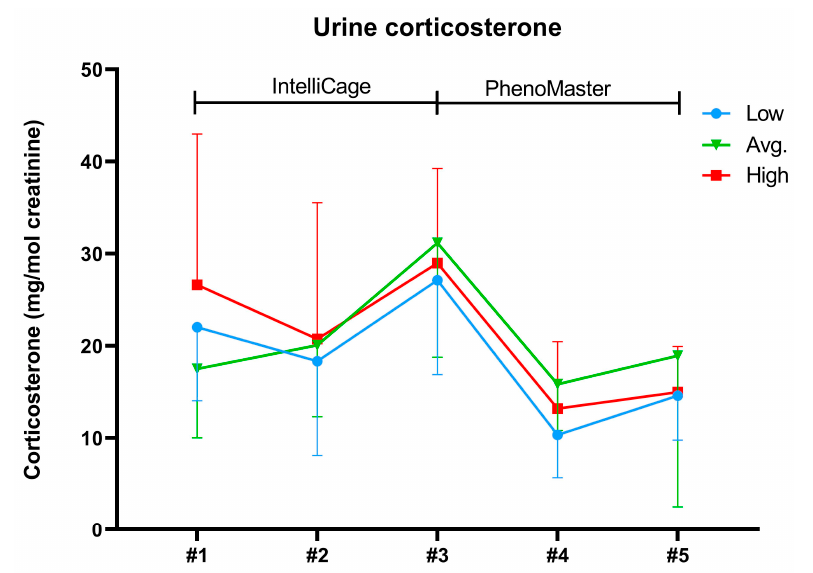
Figure 4. Urine corticosterone levels normalized to creatinine in the running wheel groups (Low; n = 7, Avg.; n = 8, High; n = 7) in sample collection points #1–#5. Data are presented as mean and standard deviation.